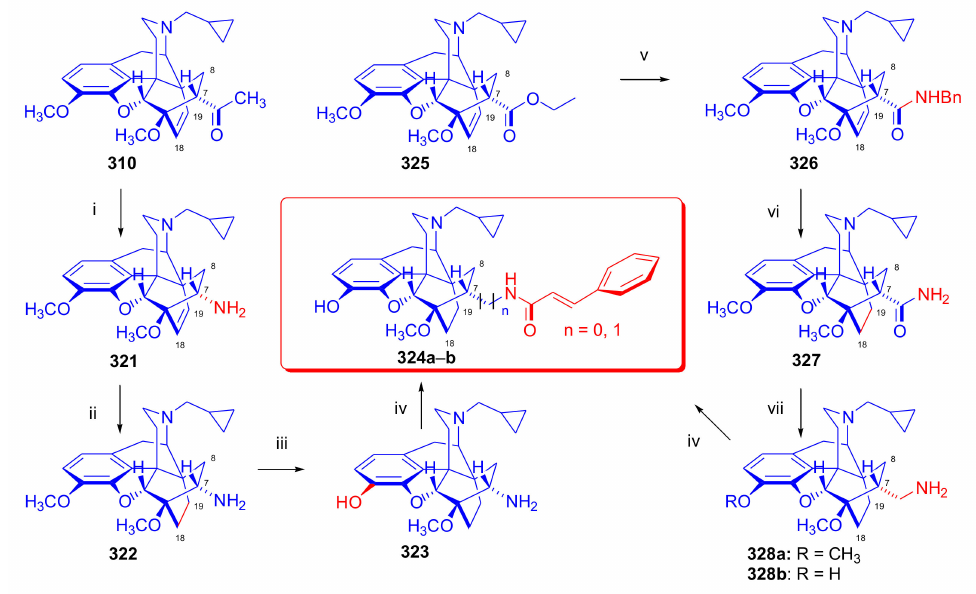
Figure 84. Synthesis of cinnamoyl derivatives of 7 α -amino- and 7 α -aminomethyl- N 17 - cyclopropylmethyl-6,14- endo -ethano-tetrahydoronororipavine. Reagents and conditions : (i): (1) HClO 4 , NaN 3 , (2) 5M HCl; (ii): H 2 , Pd-C, 2 bar, EtOH; (iii): KOH, diethylene glycol, reflux, 11 h; (iv): cin- namoyl chloride, CH 2 Cl 2 , NaHCO 3 ; (v): (1) 2M hydrochloric acid, steam bath, 3 h; (2) oxalyl chloride, CH 2 Cl 2 , DMF, nitrogen atmosphere, RT, 1.5 h; (3) benzylamine, Et 3 N, CH 2 Cl 2 ; (vi): (1) LiAlH 4 , THF, reflux, (2) H 2 , Pd-C, 45 ◦ C, 2 bar; and (vii): KOH, diethylene glycol, 8 h,